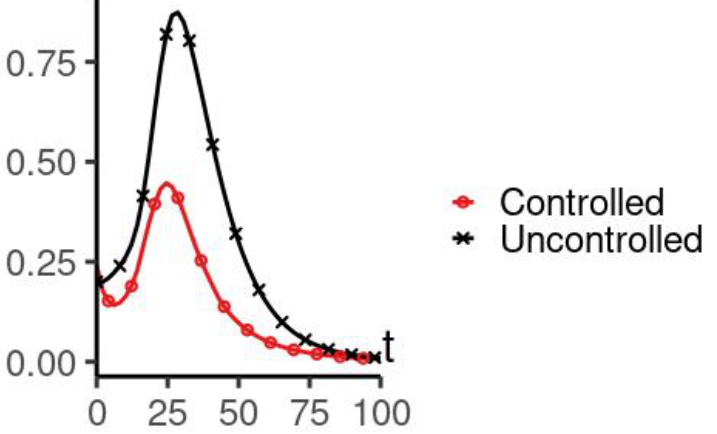
Figure 15. Experiment 2. Aggregation costs in uncontrolled and controlled